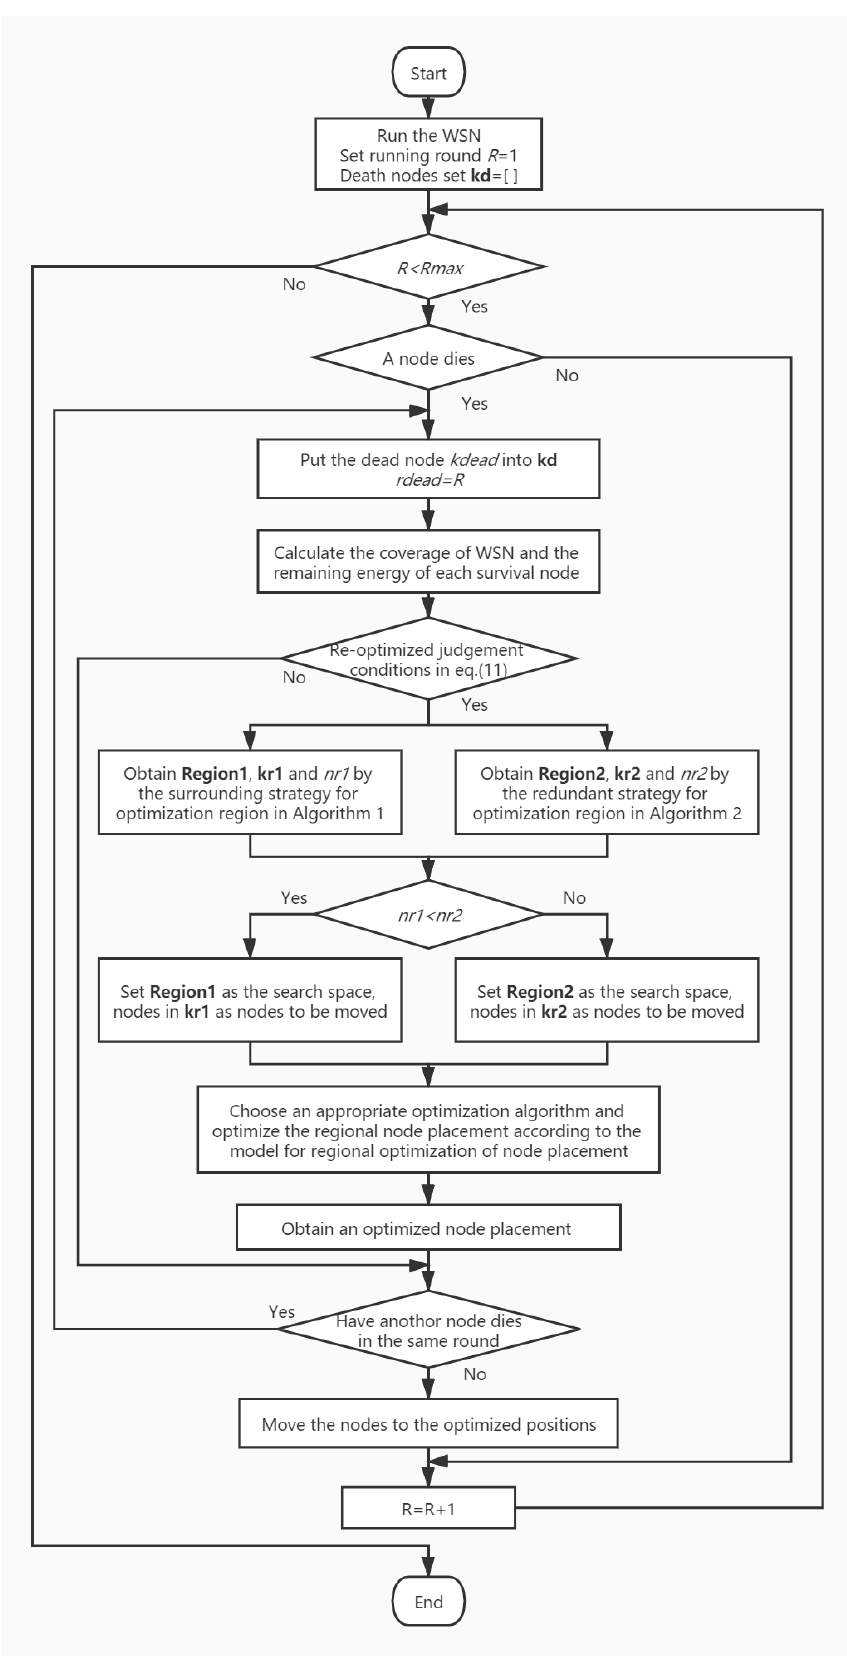
Figure 2. The flow chart of